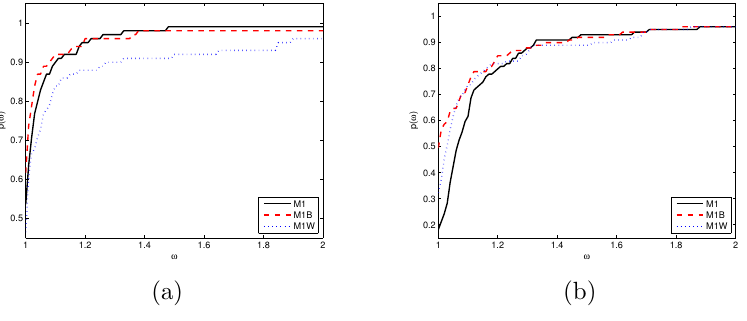
Figure 1. (a) Total number of function and gradient evaluations and (b) the CPU time performance profiles for M1, M1B and M1W.